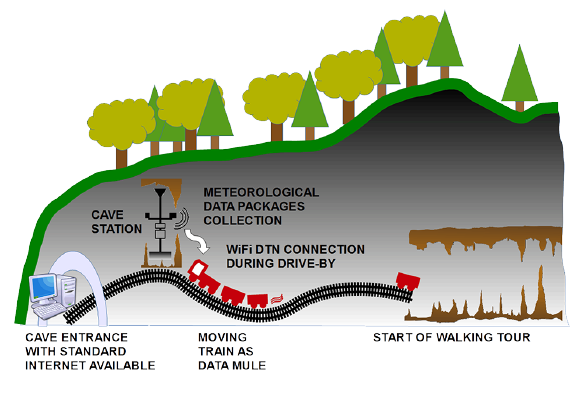
Fig. 2. Overview of the drive-by data collection test in Postojna cave.